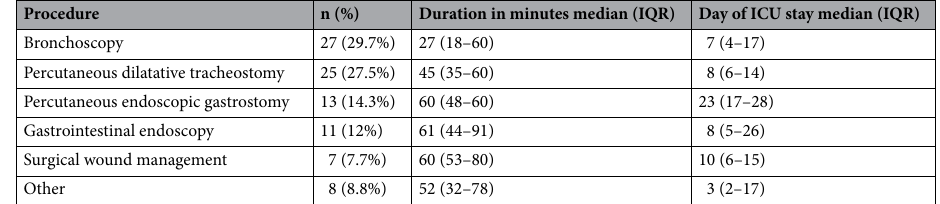
Table 2. Procedures requiring neuromuscular blockade followed by administration of sugammadex. IQR interquartile